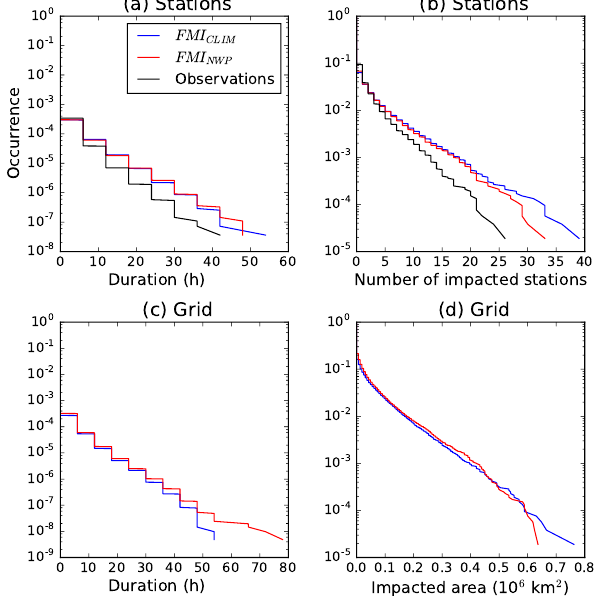
Figure 8. Probability of duration (left column) and spatial extent (right column) of FZRA events at station locations (top row) and in all grid cells (bottom row) according to the detection algorithms (blue, red) and observations (black).